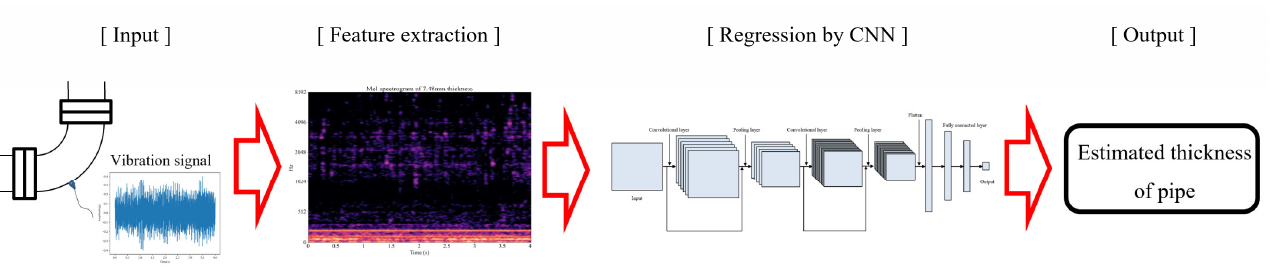
Figure 4. Wall thinning monitoring process using a deep learning model, from signal measurement to thickness estimation.